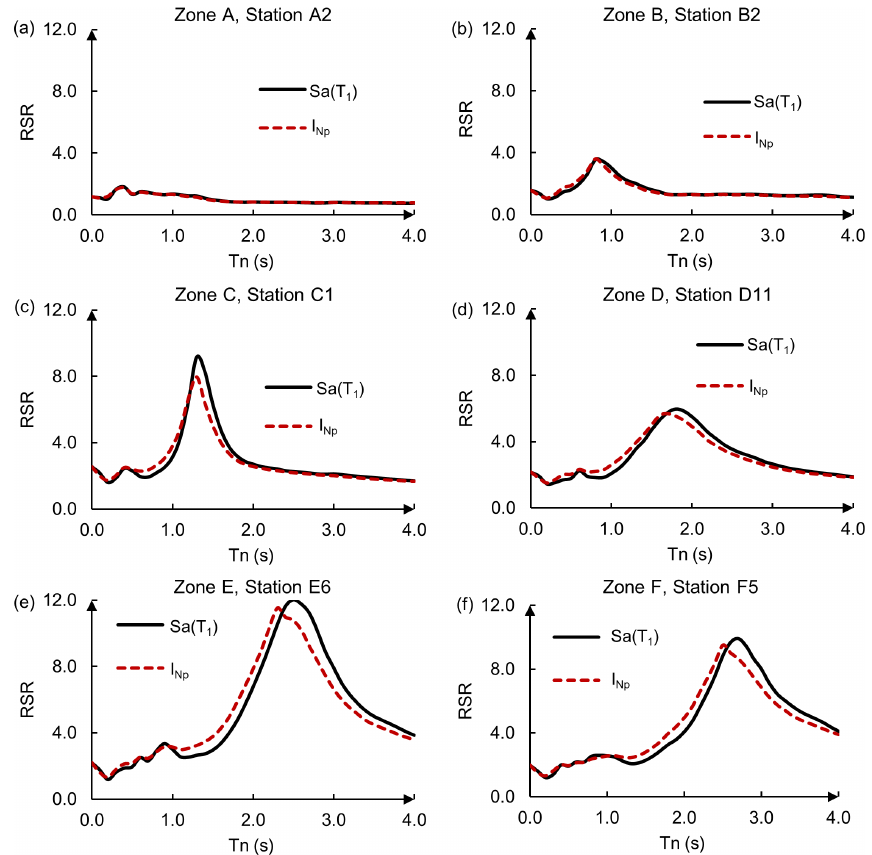
Figure 4. Mean response spectral ratios for Sa( T 1 ) and I N